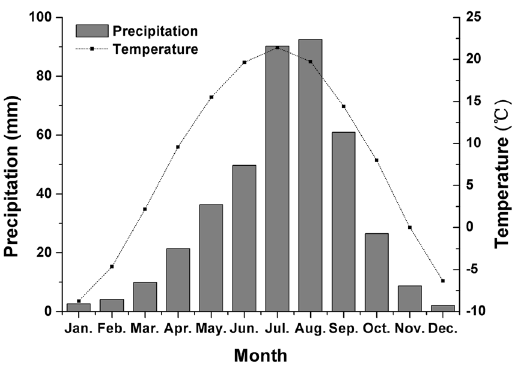
Figure 2. The average monthly precipitation and monthly mean temperature from 1958 to